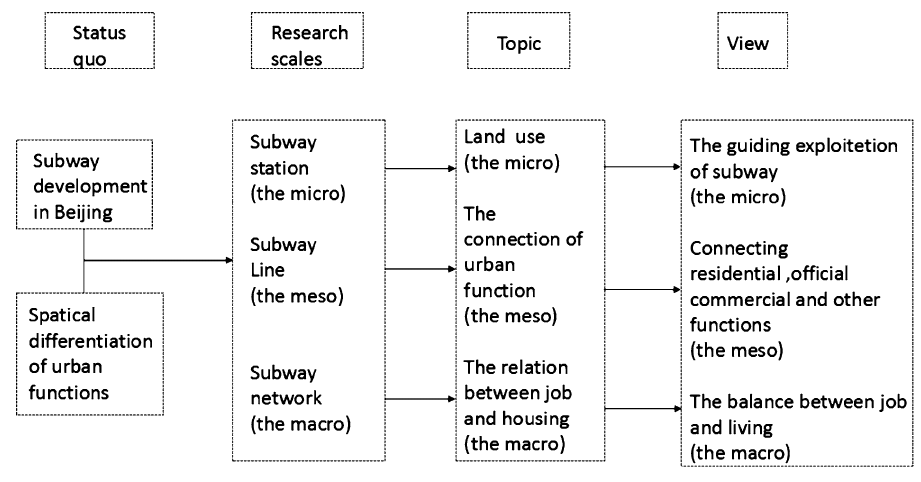
Fig. 1 Research framework of integrated development between rail transit and land